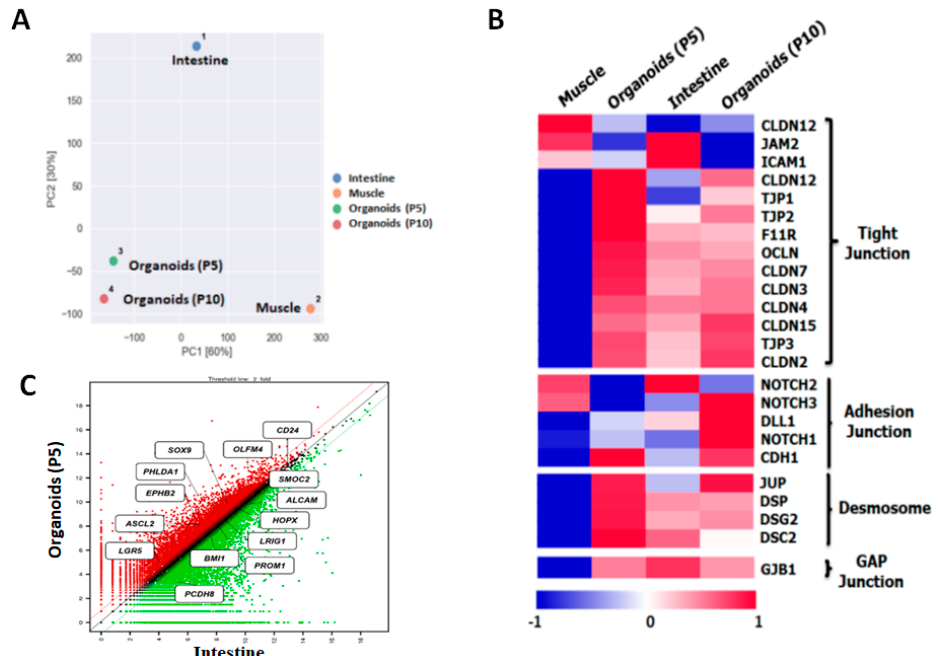
Figure 4. Gene expression profiling of bovine intestinal organoids using QuantSeq 3 ′ mRNA - Seq. Library: ( A ) principal component analysis (PCA) of intestinal organoids (P5), intestinal organoids (P10), small intestine, and muscle in bovine. The distance between intestinal organoids and the small intestine was relatively close compared to muscle; ( B ) heatmap showing many genes in epithelium-characteristic categories such as tight junctions, adherent junctions, desmosomes, and gap junctions. Intestinal organoids at P5 and P10 and in the small intestine were significantly expressed compared to muscle as a control; ( C ) scatter plot showing many genes related to intestinal stem cell markers such as LGR5 , ASCL2 , EPHB2 , PHLDA1 , SOX9 , and OLFM4 . Intestinal organoids at P5 were significantly upregulated or similar between intestinal organoids and the